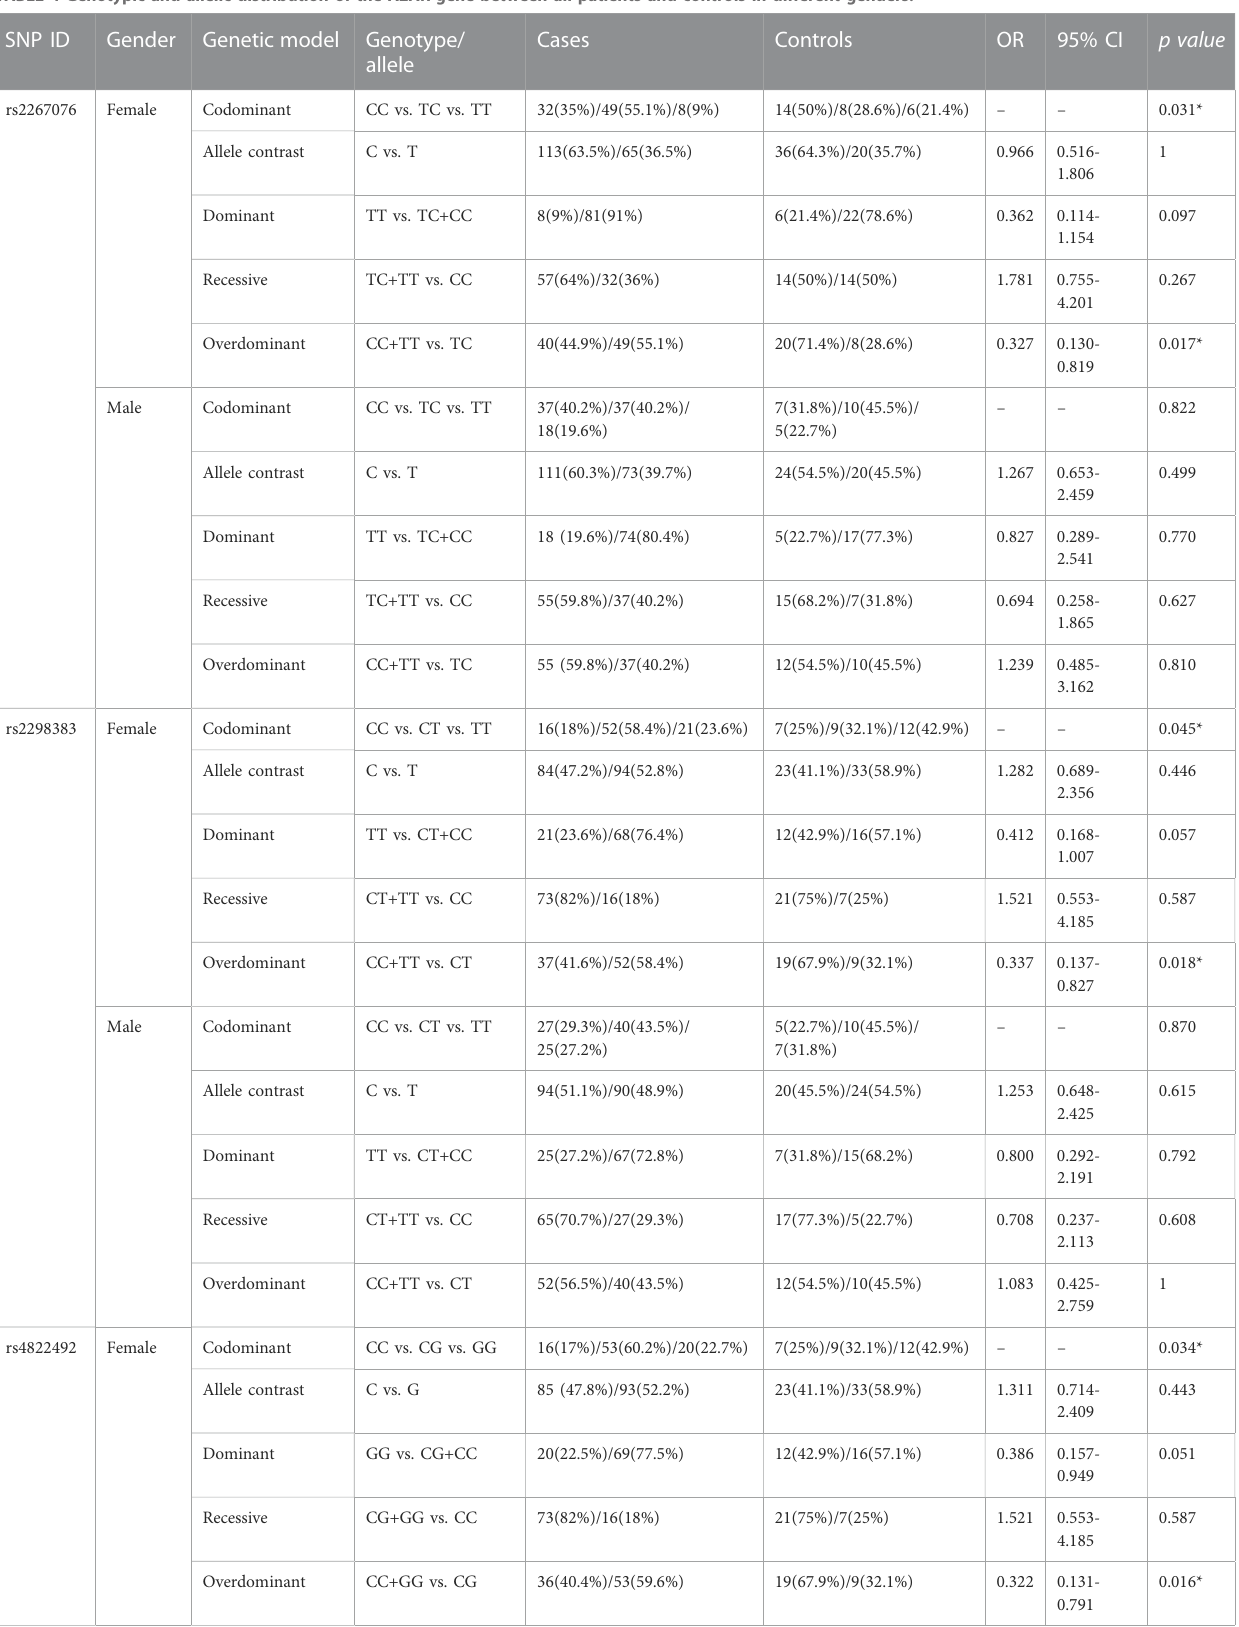
TABLE 4 Genotypic and allelic distribution of the A2AR gene between all patients and controls in different